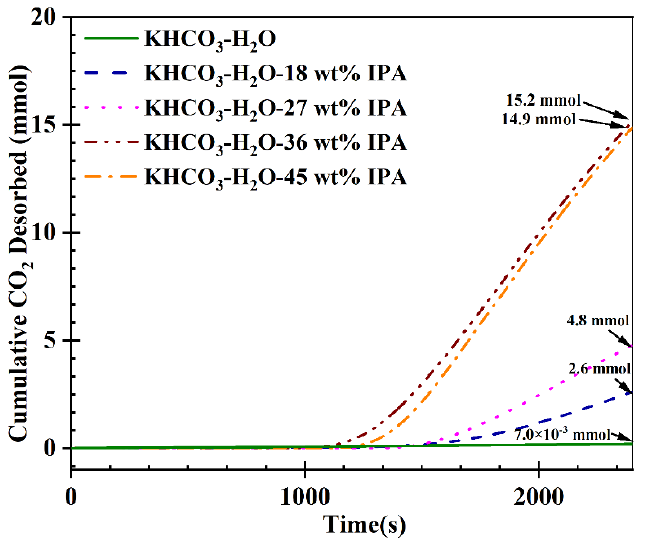
Figure 5. Effect on IPA concentration on CO 2 desorption in KHCO 3 − H 2 O and KHCO 3 − H 2 O − IPA solutions.